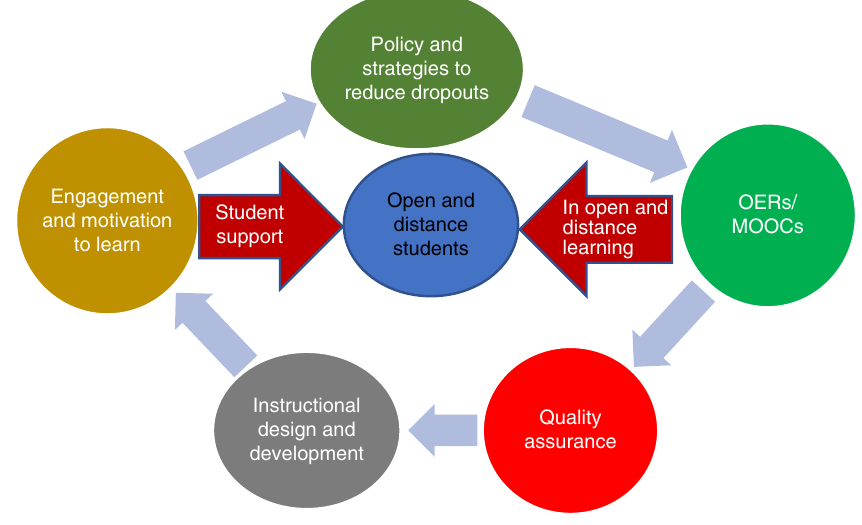
Figure 1. Conceptual framework for student support services in open and distance